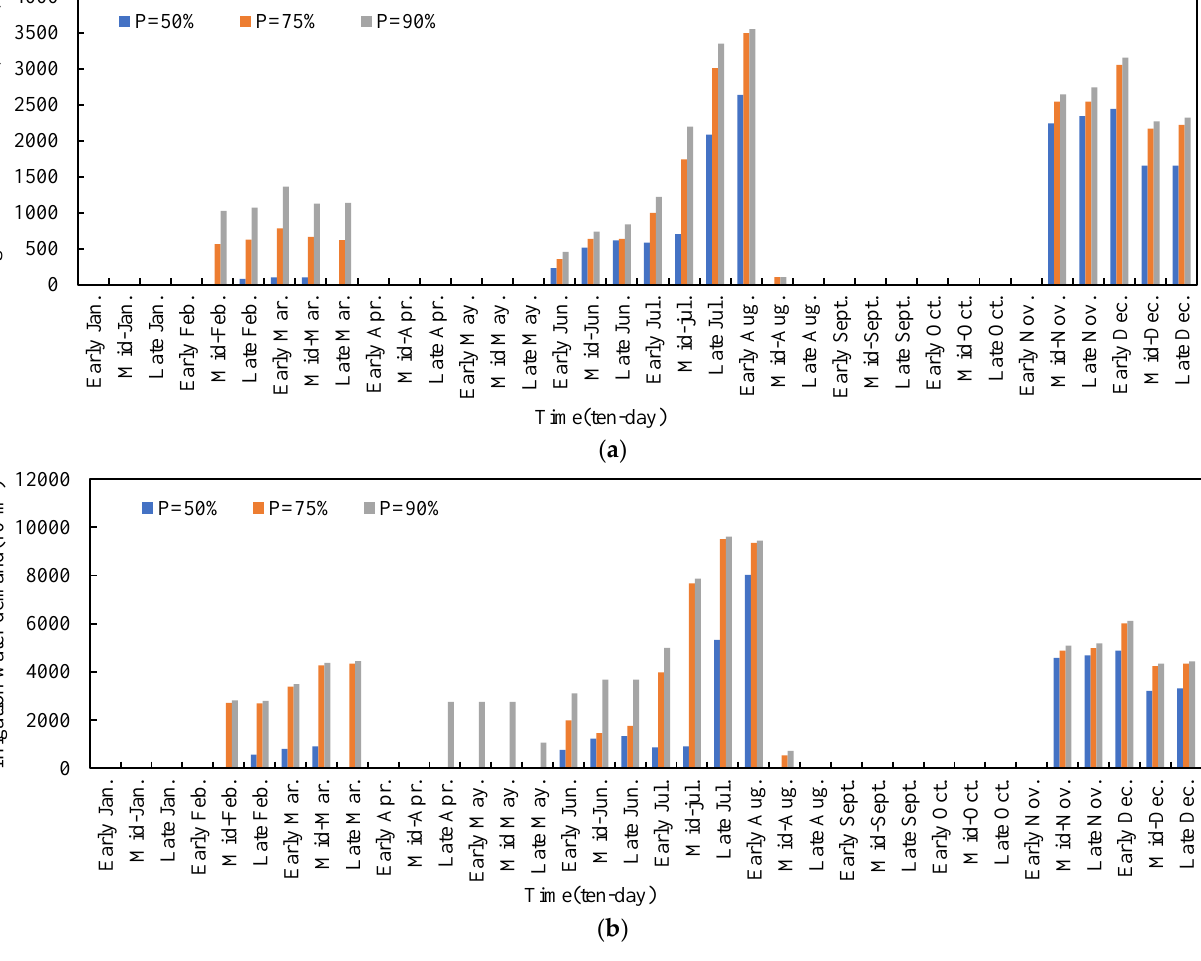
Figure 5. Irrigation water demand processes for different typical years: ( a ) basic irrigation water demand; ( b ) maximum irrigation water demand. Table 1. Basic and maximum ecological base flow of Linjiacun Section (m 3 /s).